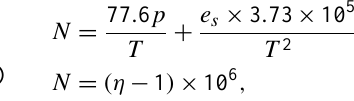
dard η ) + PF (time-varying) + SF (standard) + SF (time- varying) + ASF (nominal, static) + ASF (time-varying)).